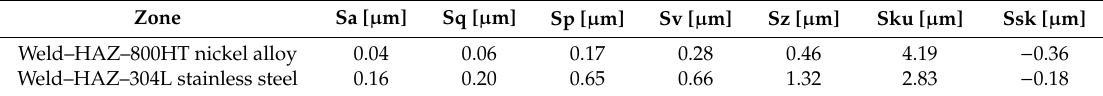
Table 6. 3D surface texture parameters of the specimens under investigation.